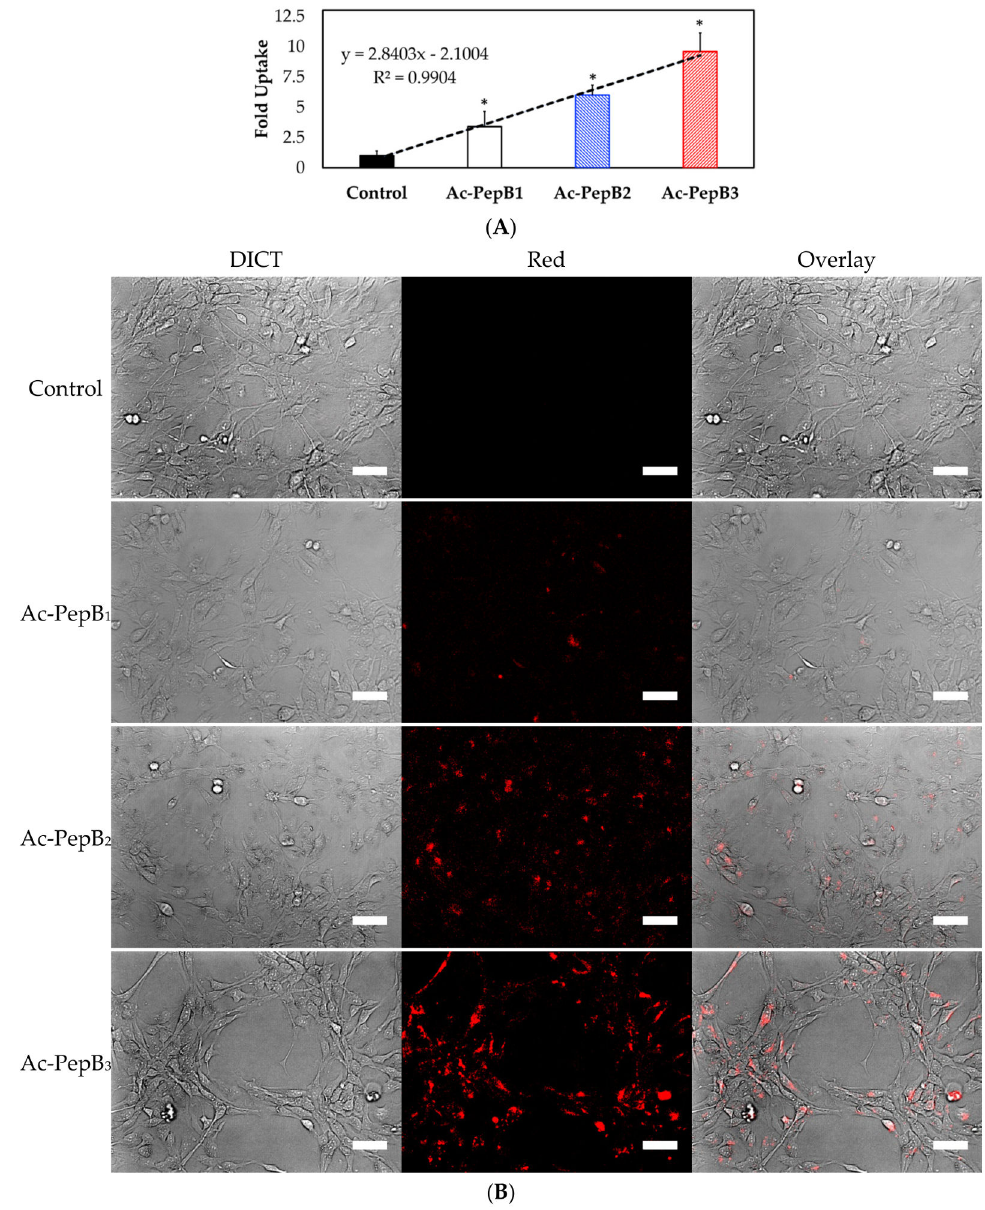
Figure 9. PepB series uptake results on RVM cells. ( A ) Flow cytometry results showed Ac-PepB repeat sequence-dependent cell uptake in RVM. ( B ) Live-cell fluorescence microscopy images of RVM after 24 h treatment with 1 µ M Ac-PepB. N = 3; error bars depicted as SD; * p < 0.001; scale bar = 50 µ m.